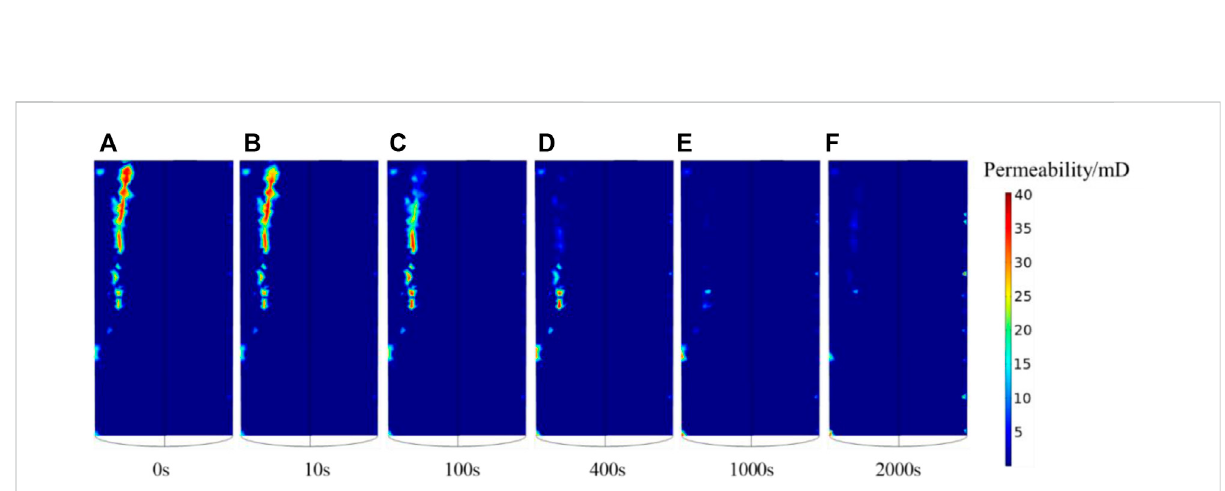
FIGURE 11 Cloud map of permeability variation with time. (A – F) refers to the permeability clouds at different times, in accordance with the numerical simulation speci fi